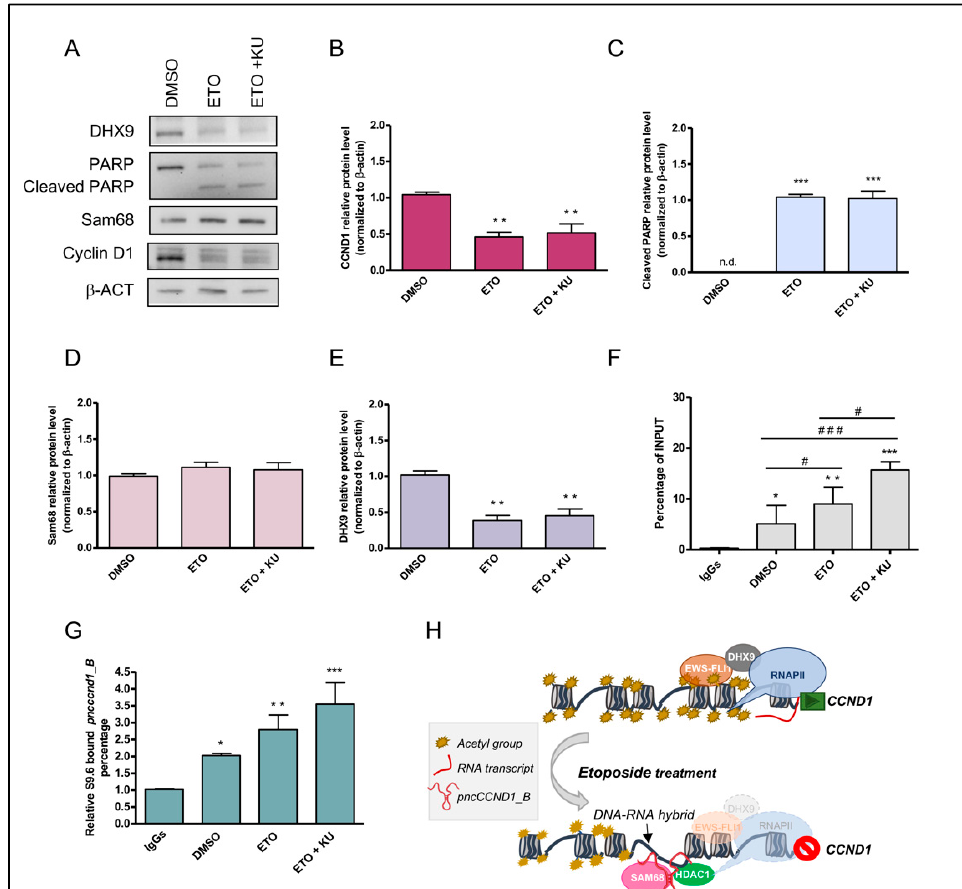
Figure 6. DNA:RNA heteroduplex formation, caused by DHX9 repression, impairs transcription at the CCND1 promoter. ( A ) Representative western blot upon treatment with DMSO (vehicle), 5 µM etoposide (ETO), and combination of etoposide and KU 55933 (10 µM) (ETO + KU). Histograms represent DHX9 ( B ), cleaved PARP1 ( C ) (n.d. not detectable), Sam68 ( D ), and CCND1 ( E ) protein levels normalized to β -actin, relative to DMSO. ( F ) qPCR analysis of the promoter region of CCND1 gene on S9.6 immunoprecipitated chromatin (DRIP experiment). ( G ) RT-qPCR analysis of pncCCND1_B in DNA:RNA immunoprecipitated heteroduplexes (CARIP experiment). Statistical analysis was performed by ANOVA with Bonferroni correction ANOVA. ( B – G ) p -value (*, # < 0.05, ** < 0.01, ***, ### < 0.005). ( H ) Schematic representation of the CCND1 promoter region. Acetylation of